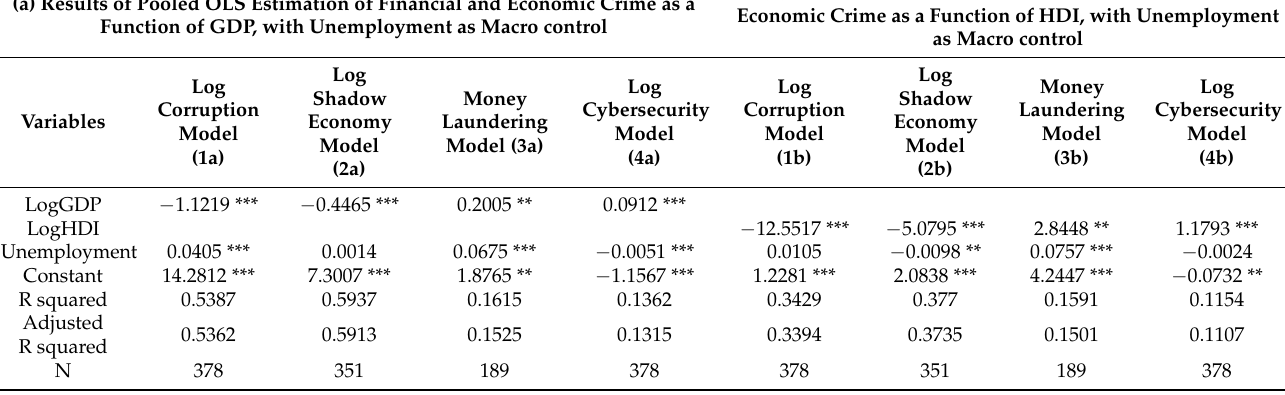
(b) Results of Pooled OLS Estimation of Financial and Economic Crime as a Function of HDI, with Unemployment as Macro